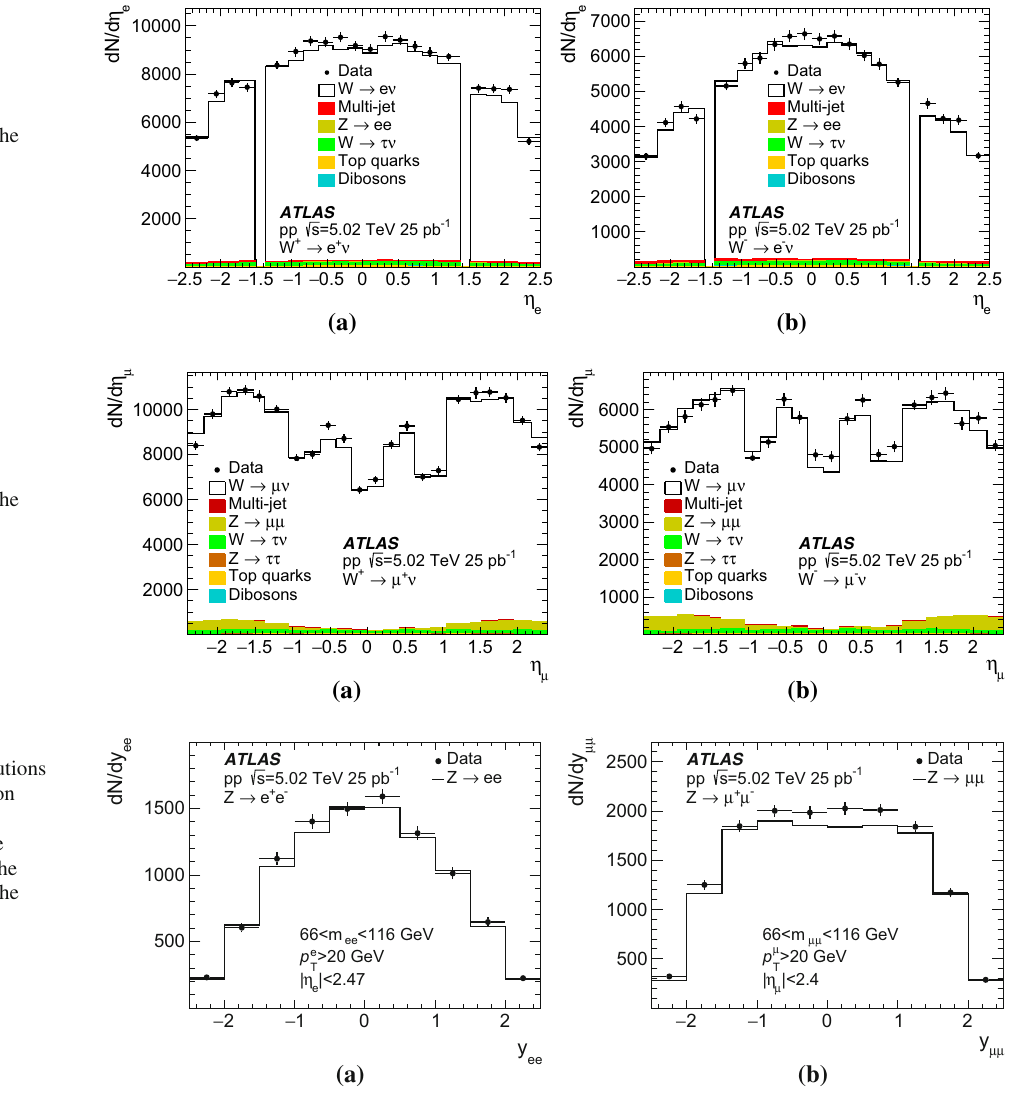
Fig. 7 Detector-level lepton-pair rapidity distributions in the a electron and b muon channels. Background contributions are negligible using a linear scale. Only the statistical uncertainties of the data are